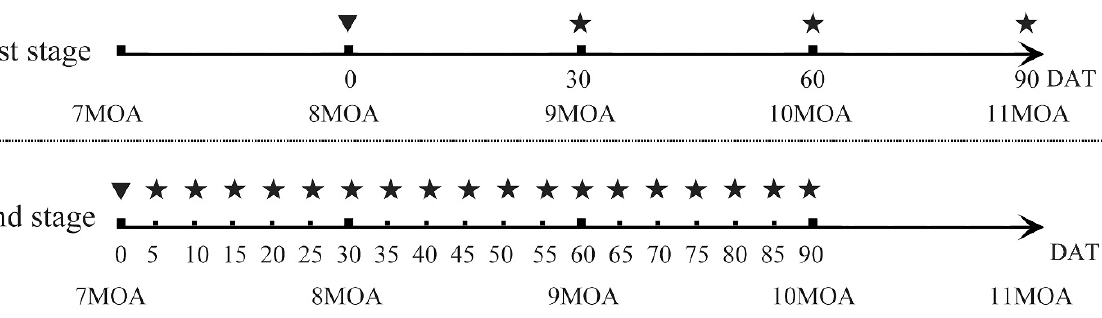
Figure 1. Sampling time points in the TH treatment group. A triangle represents the time point at which the TH treatment began; a pentagram represents a time point at which samples were